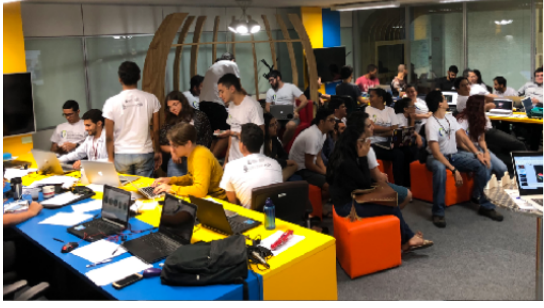
Figure 5. Hackathon participants in